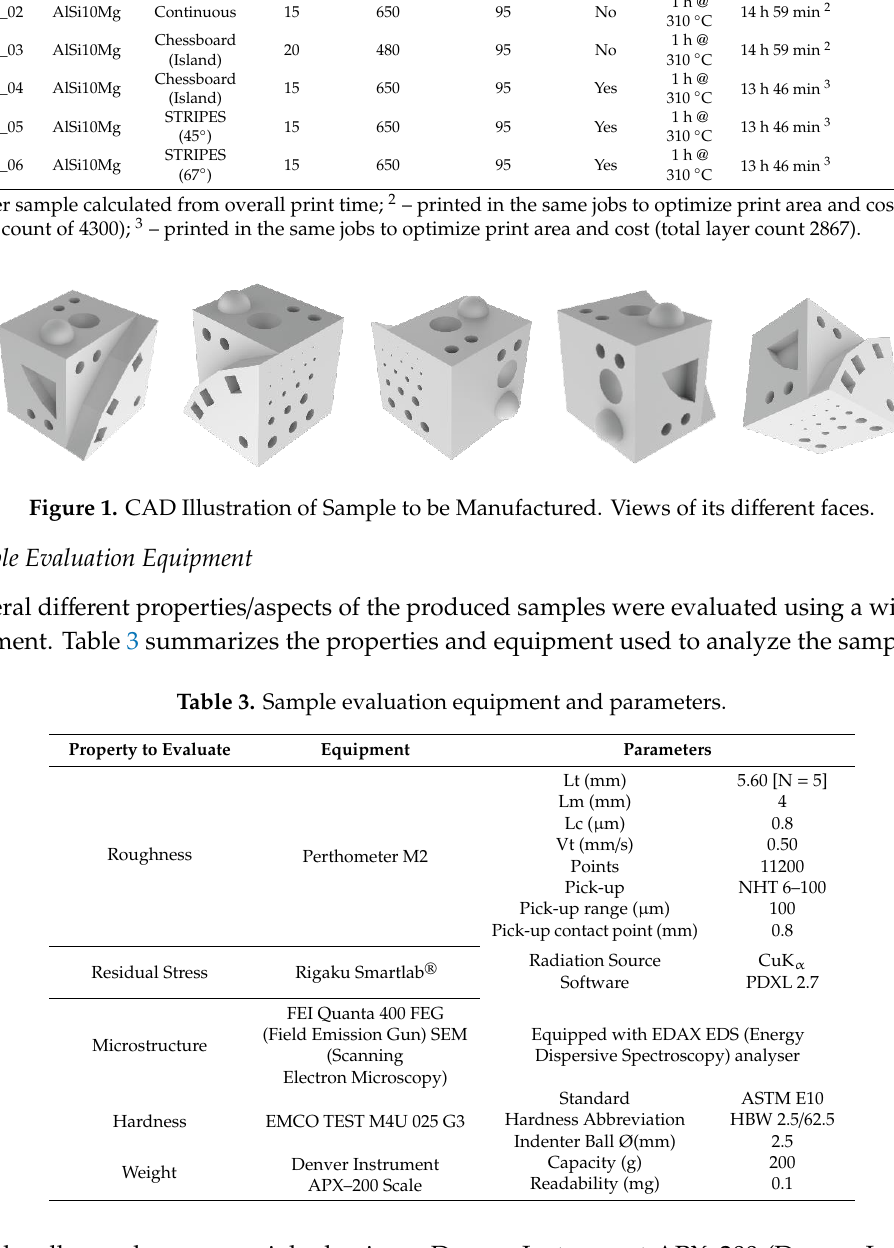
Table 2. Selected AM Process Parameters.